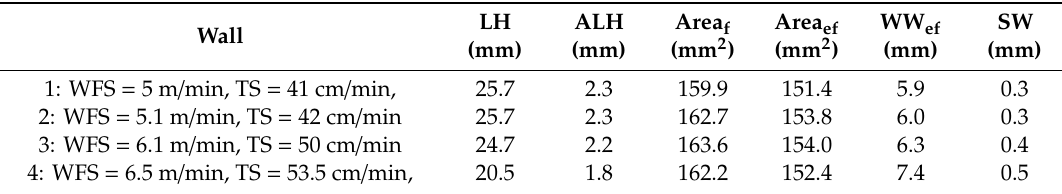
Table 4. Geometrical parameters of the built